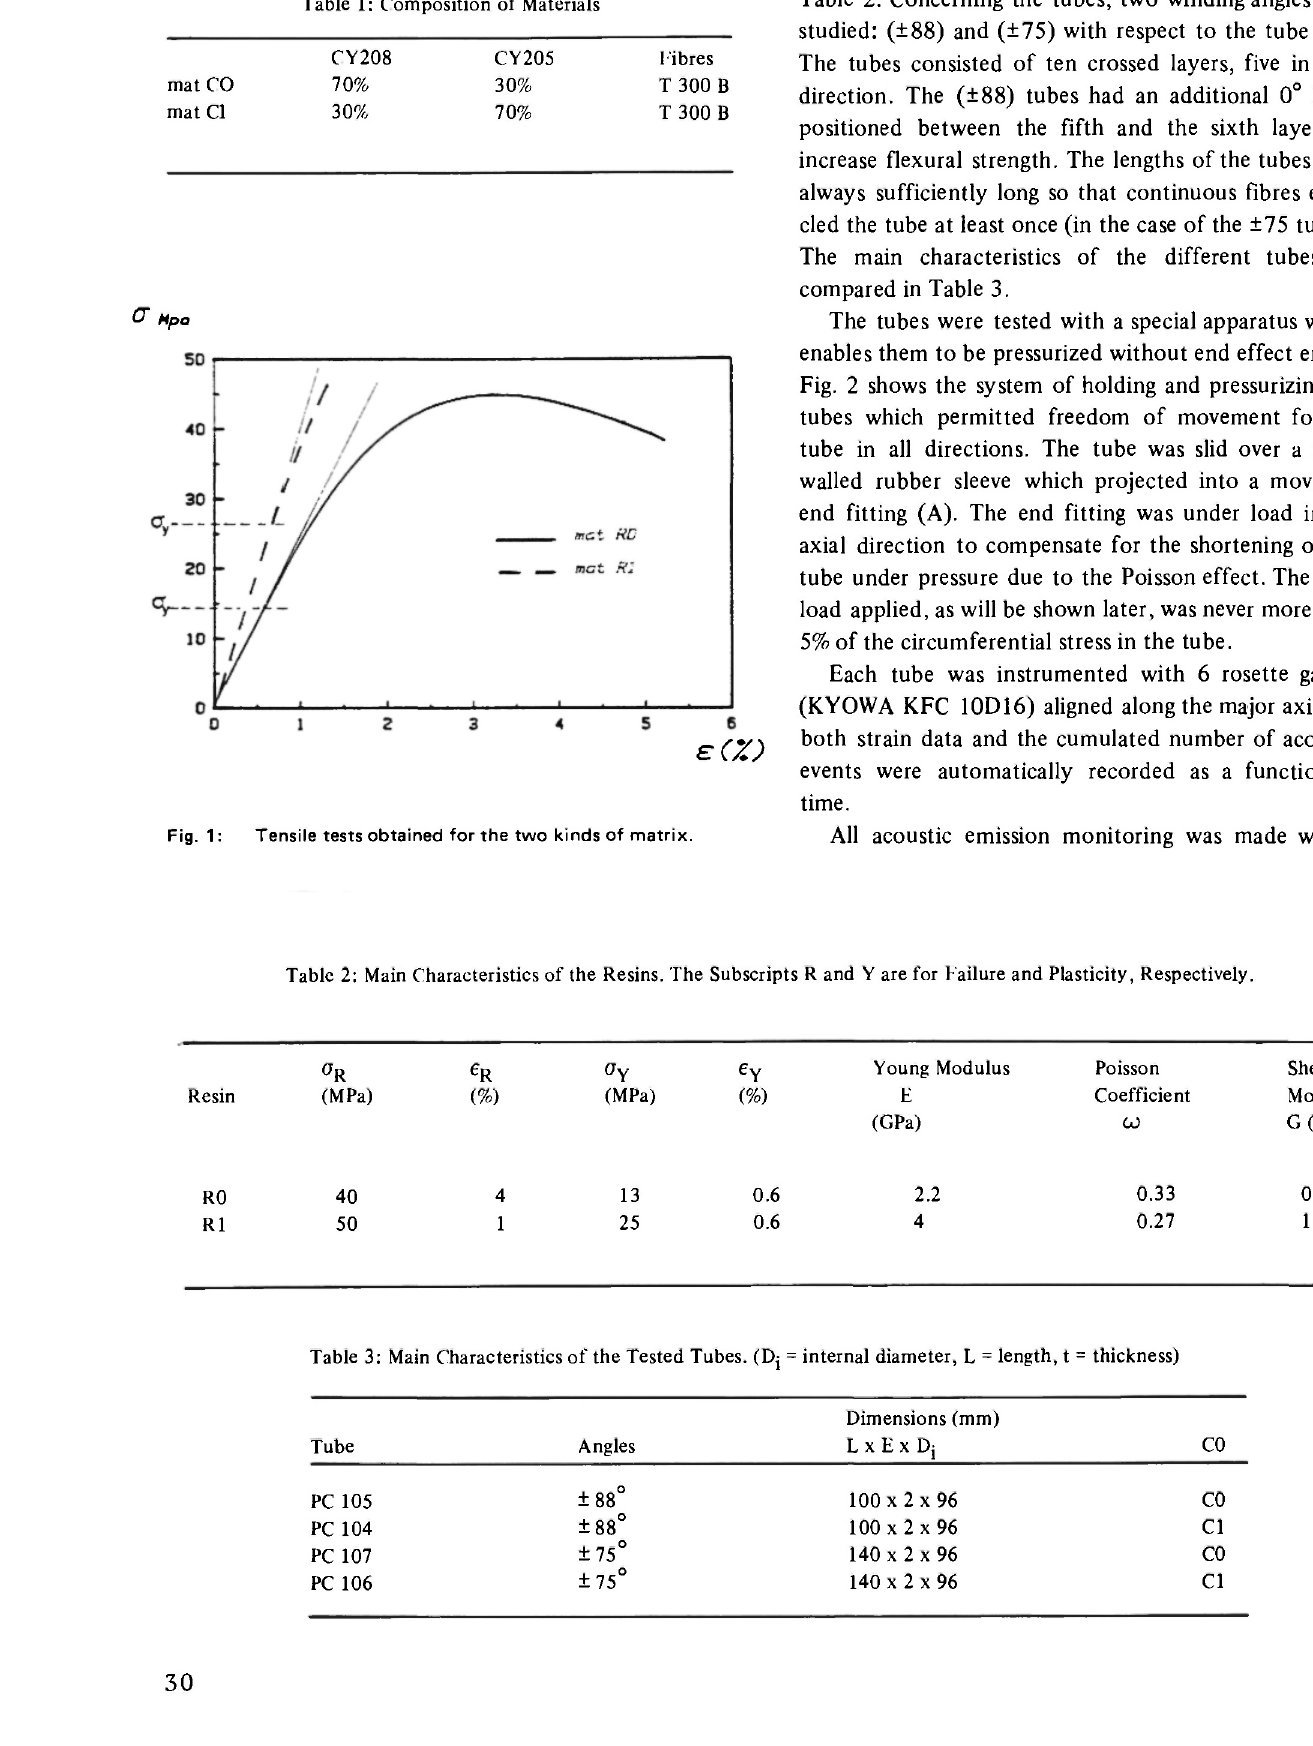
Table 3: Main Characteristics of the Tested Tubes. (Dj = internal diameter, L = length, t =